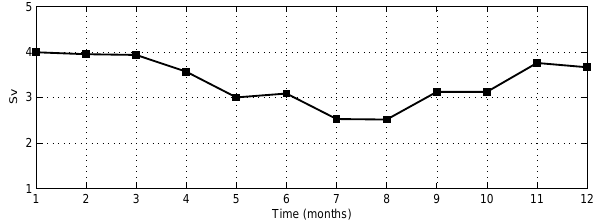
Fig. 7. Monthly mean time series of the eastward flow [Sv] at the section Sardinia-Tunisia computed averaging the daily data from January 2008 to December 2010